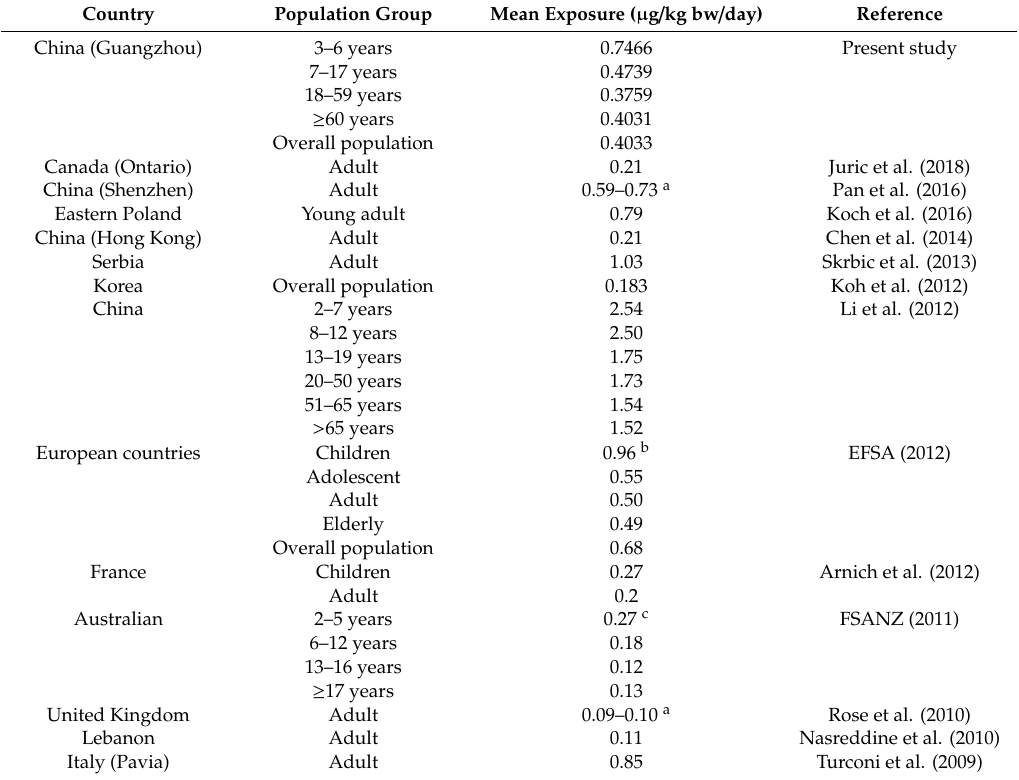
Table 5. Comparison of dietary lead exposure in Guangzhou with other data from the total diet